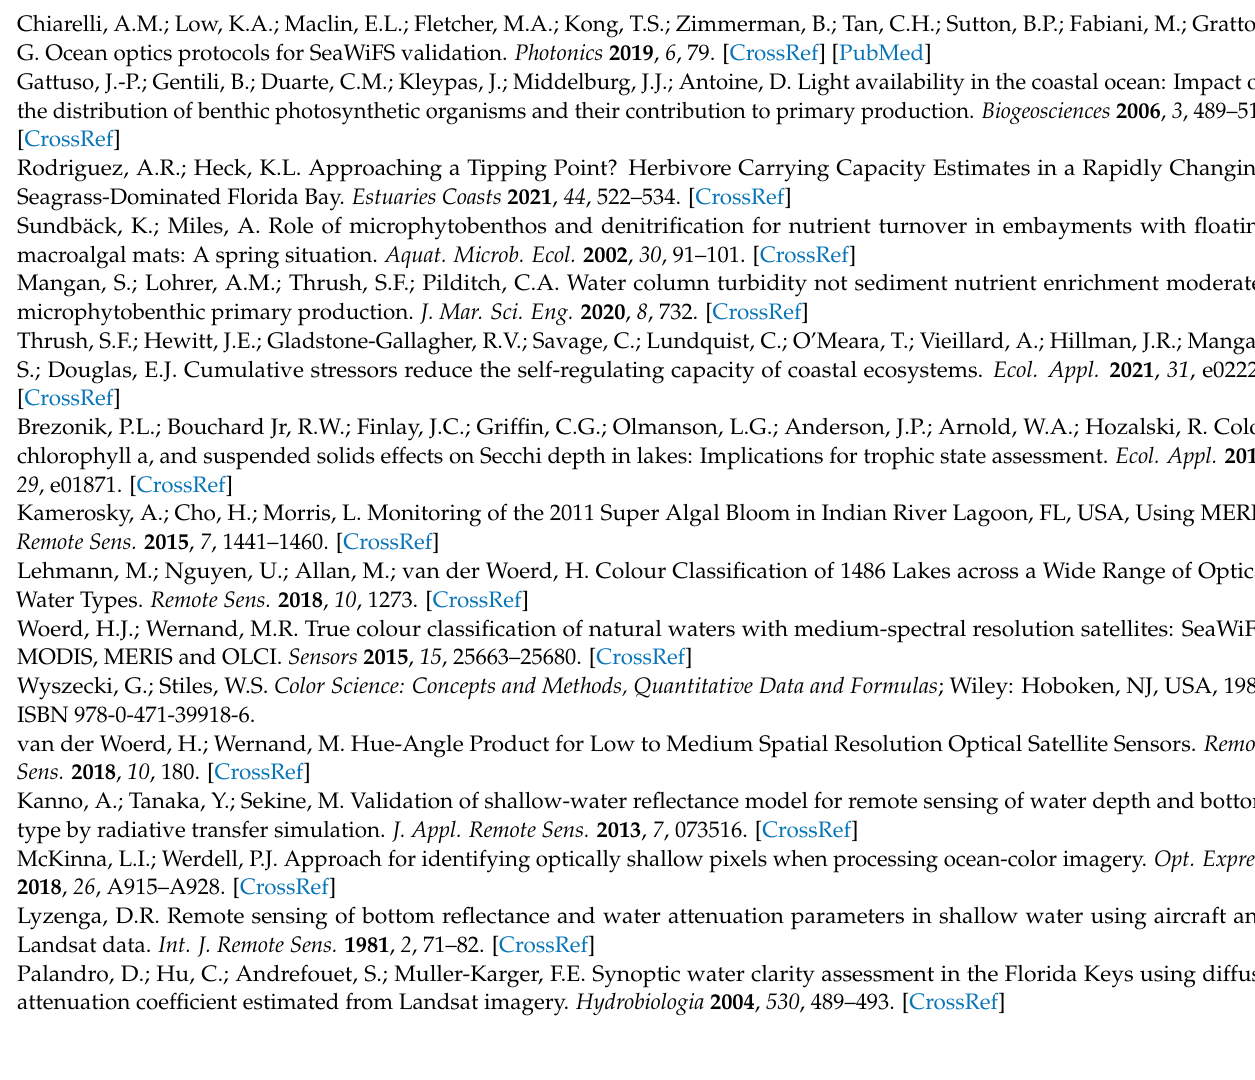
Figure A3. The errors of R w and K d averaged for water depths of <2 m ( a ) and between 2 m and 6 m ( b ) are caused by an error in the value of R b .